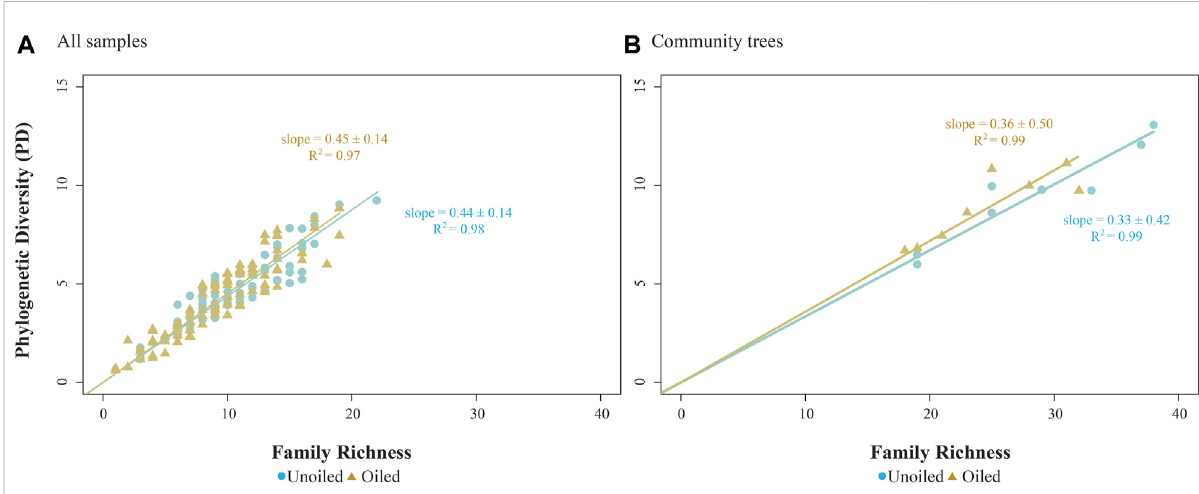
FIGURE 3 Scatterplot of PD and family richness values calculated for (A) all samples, and (B) each of the 16 community trees, separated by site. Linear regression lines constrained through the origin are given for each site, with slope ± 95% con fi dence interval and R 2